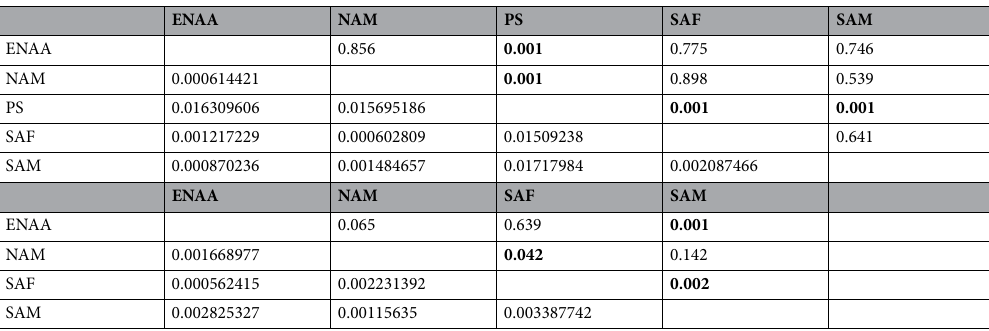
Table 1. Pairwise comparisons of the sum of variances for the morphological disparity between the extant clades and the fossil angel shark. Upper triangle of values indicates p value and lower triangle the pairwise distance between the variance of each group. Bold values in the upper triangle indicate significant differences at p < 0.05.